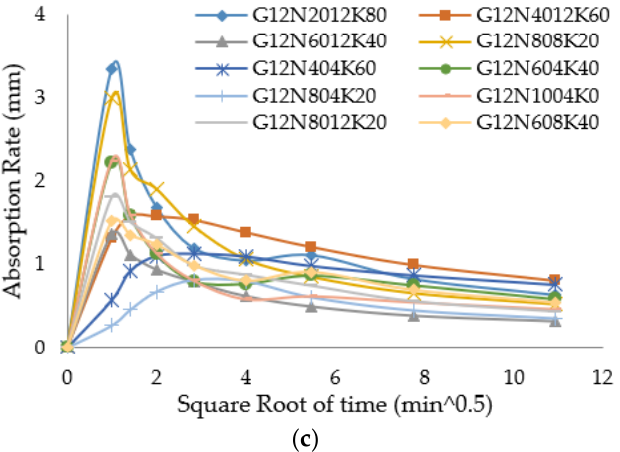
Figure 6. Absorption rate of geopolymer cement paste at 28 days: ( a ) for 4 M samples, ( b ) for 8 M samples, and ( c ) for 12 M samples.